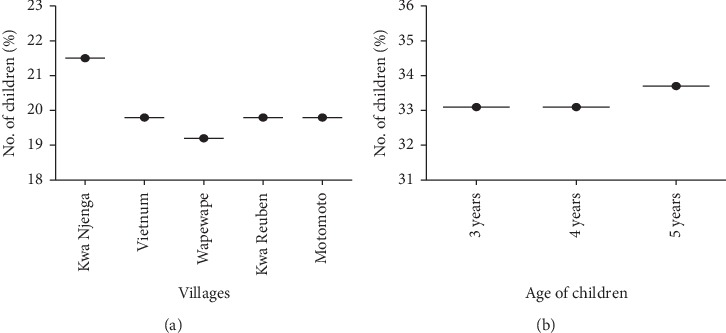
The distribution of children sampled for the study. (a) Distribution of children per village. (b) Age distribution of children.